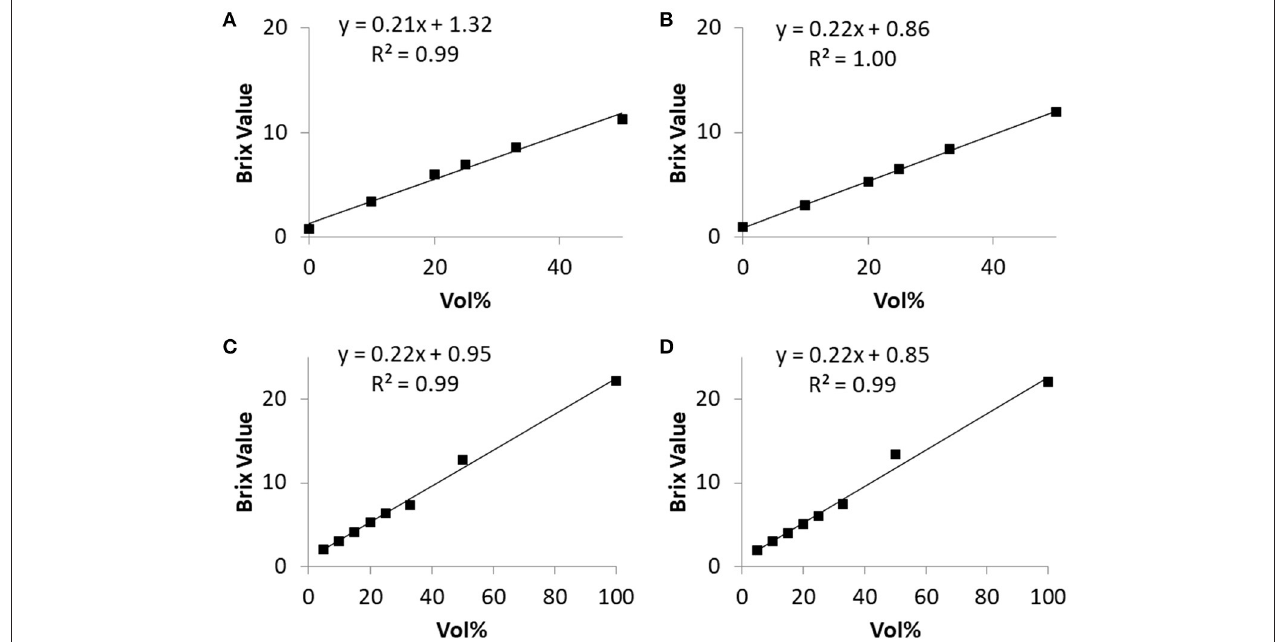
FIGURE 3 | Relationship between Brix Value and nutrition formula concentration before and after 240-min incubation in simulated gastric fluid. (A,B) Fresubin Energy Drink before (A) and after (B) incubation. (C,D) Fresubin Original Fiber before (C) and after (D) incubation. Data points represent mean values of three (A,B) or two (C,D) independent samples, respectively. The normalized standard error of the slope of the regression line was 6.1% for (A) , 1.1% for (B) , 2.9% for (C) , and 3.9% for (D) .